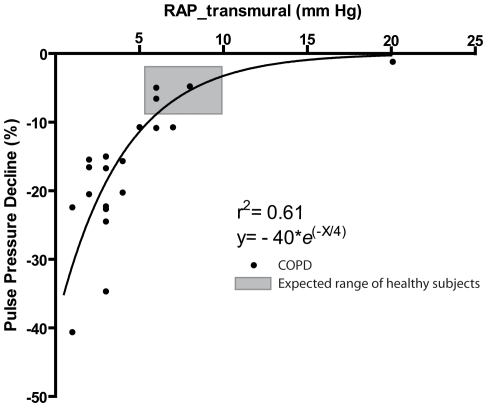
Relationship between transmural pressure of the right atrium (RAP_tm) and the percent decline in pulse pressure in the pulmonary artery.Gray area represents the suspected window of normal, based on the calculated pulse pressure decline and the suspected RAP_tm of the control subjects.